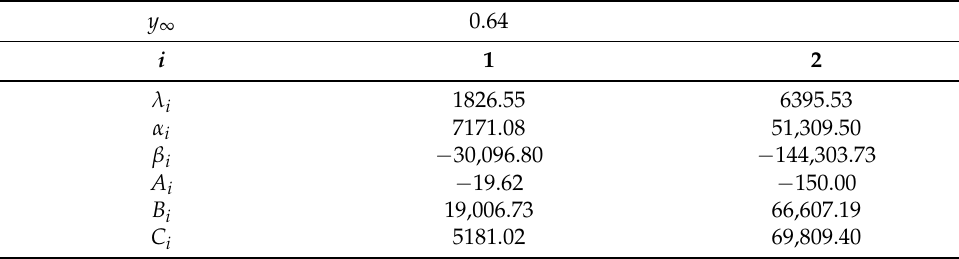
Table A2. Values of y ∞ , λ i , α i , β i , A i , B i and C i for NF.